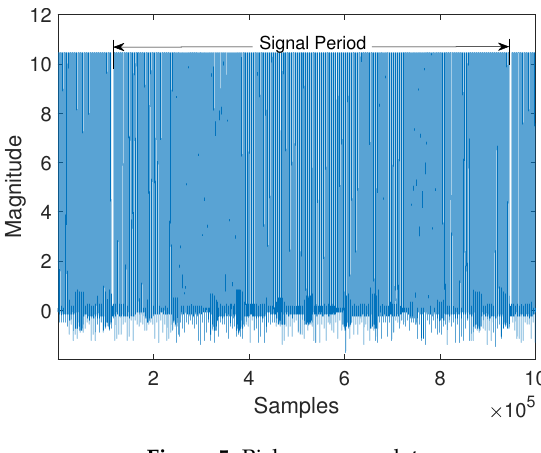
Figure 5. Pickup sensor